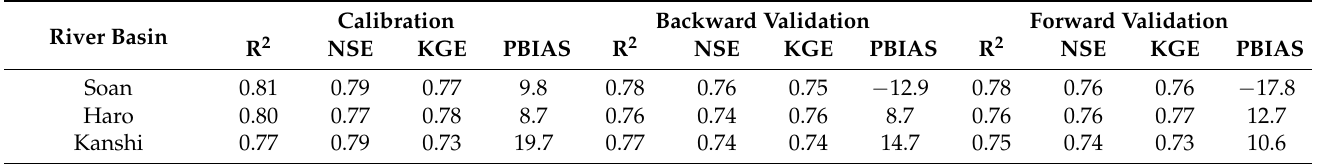
Table 5. Statistical performance of model during calibration and validation